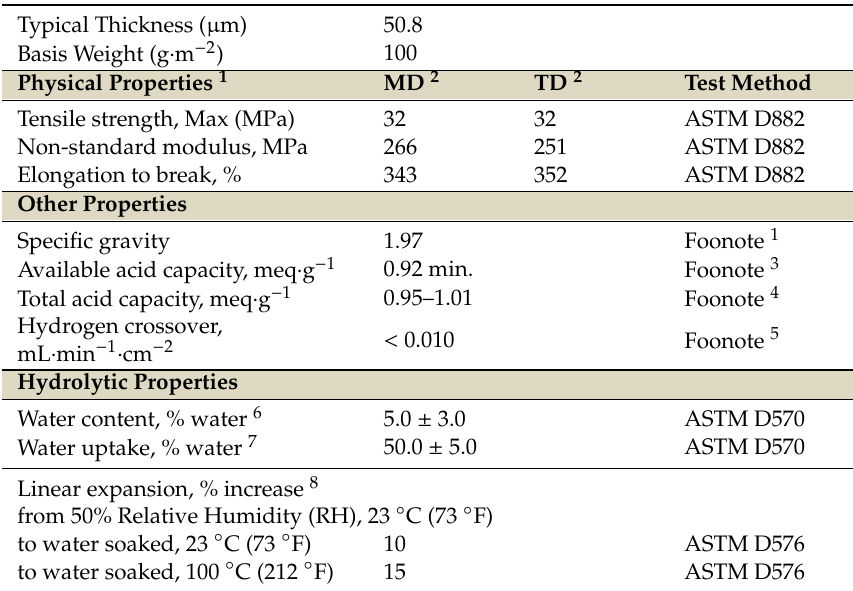
Table 1. Main properties of Nafion ™ NR212 membrane as reported by Ion Power ®